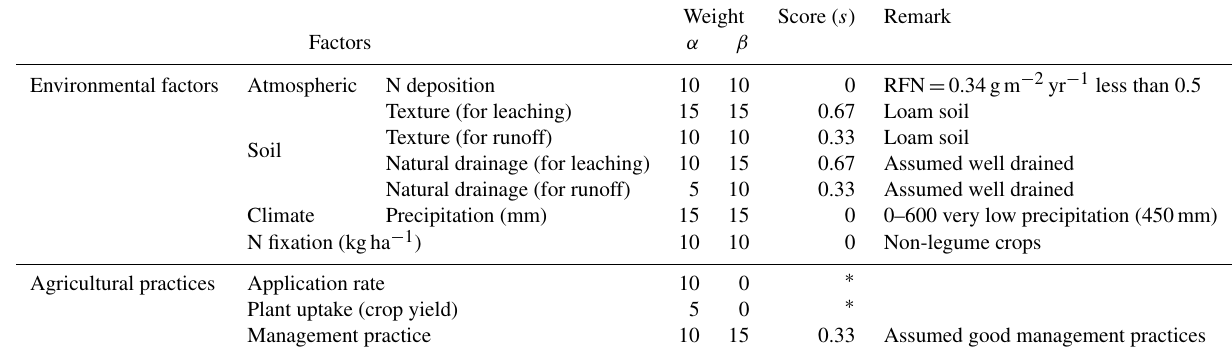
Table A3. N leaching–runoff potential scores for environmental factors and agricultural practices, following the tier-1 approach (Franke et al.,